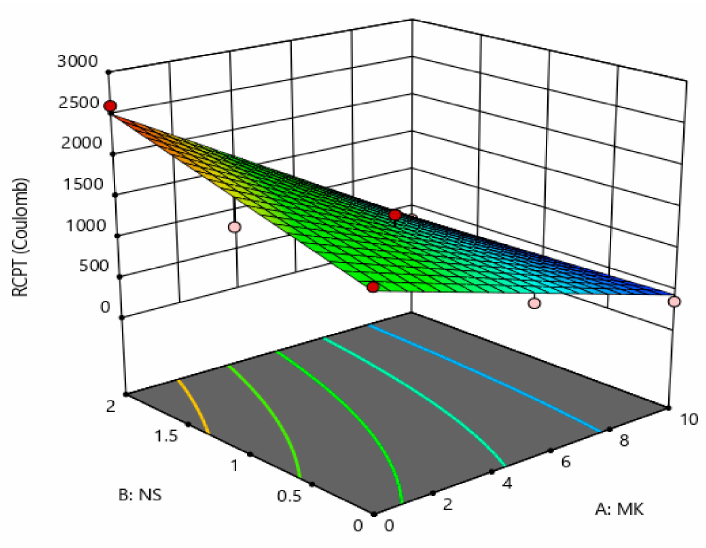
Figure 14. E ff ect MK and NS proportions on charge passing. Table 5. Coe ffi cients of a mathematical equation of concrete properties.